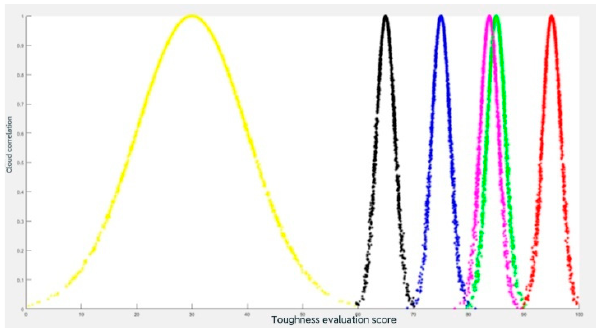
Figure 7. Cloud chart of overall target resilience evaluation level.